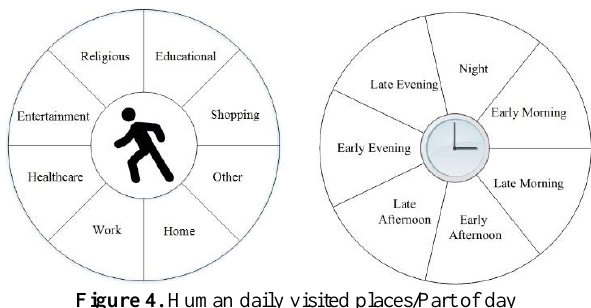
Figure 4. Human daily visited places/Part of